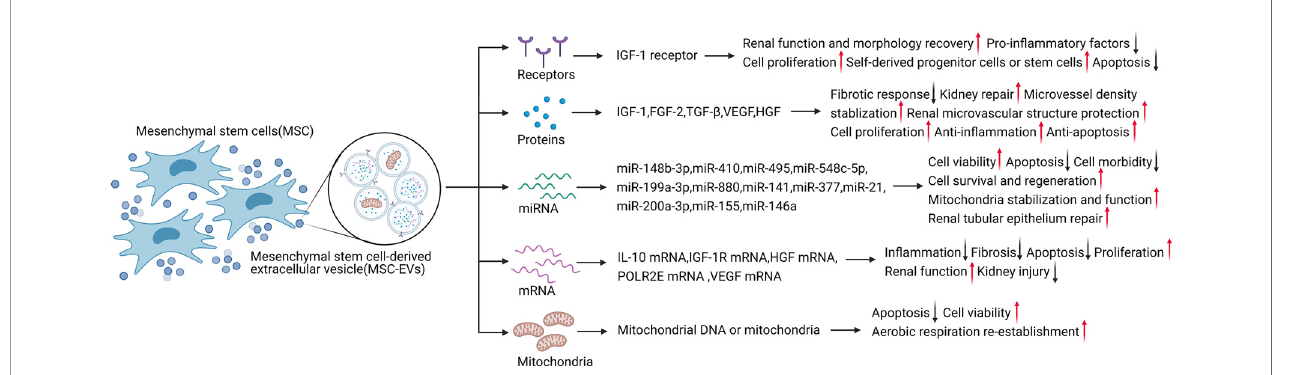
FIGURE 2 | MSC-EVs carry various contents to exert therapeutic effects in AKI. Created